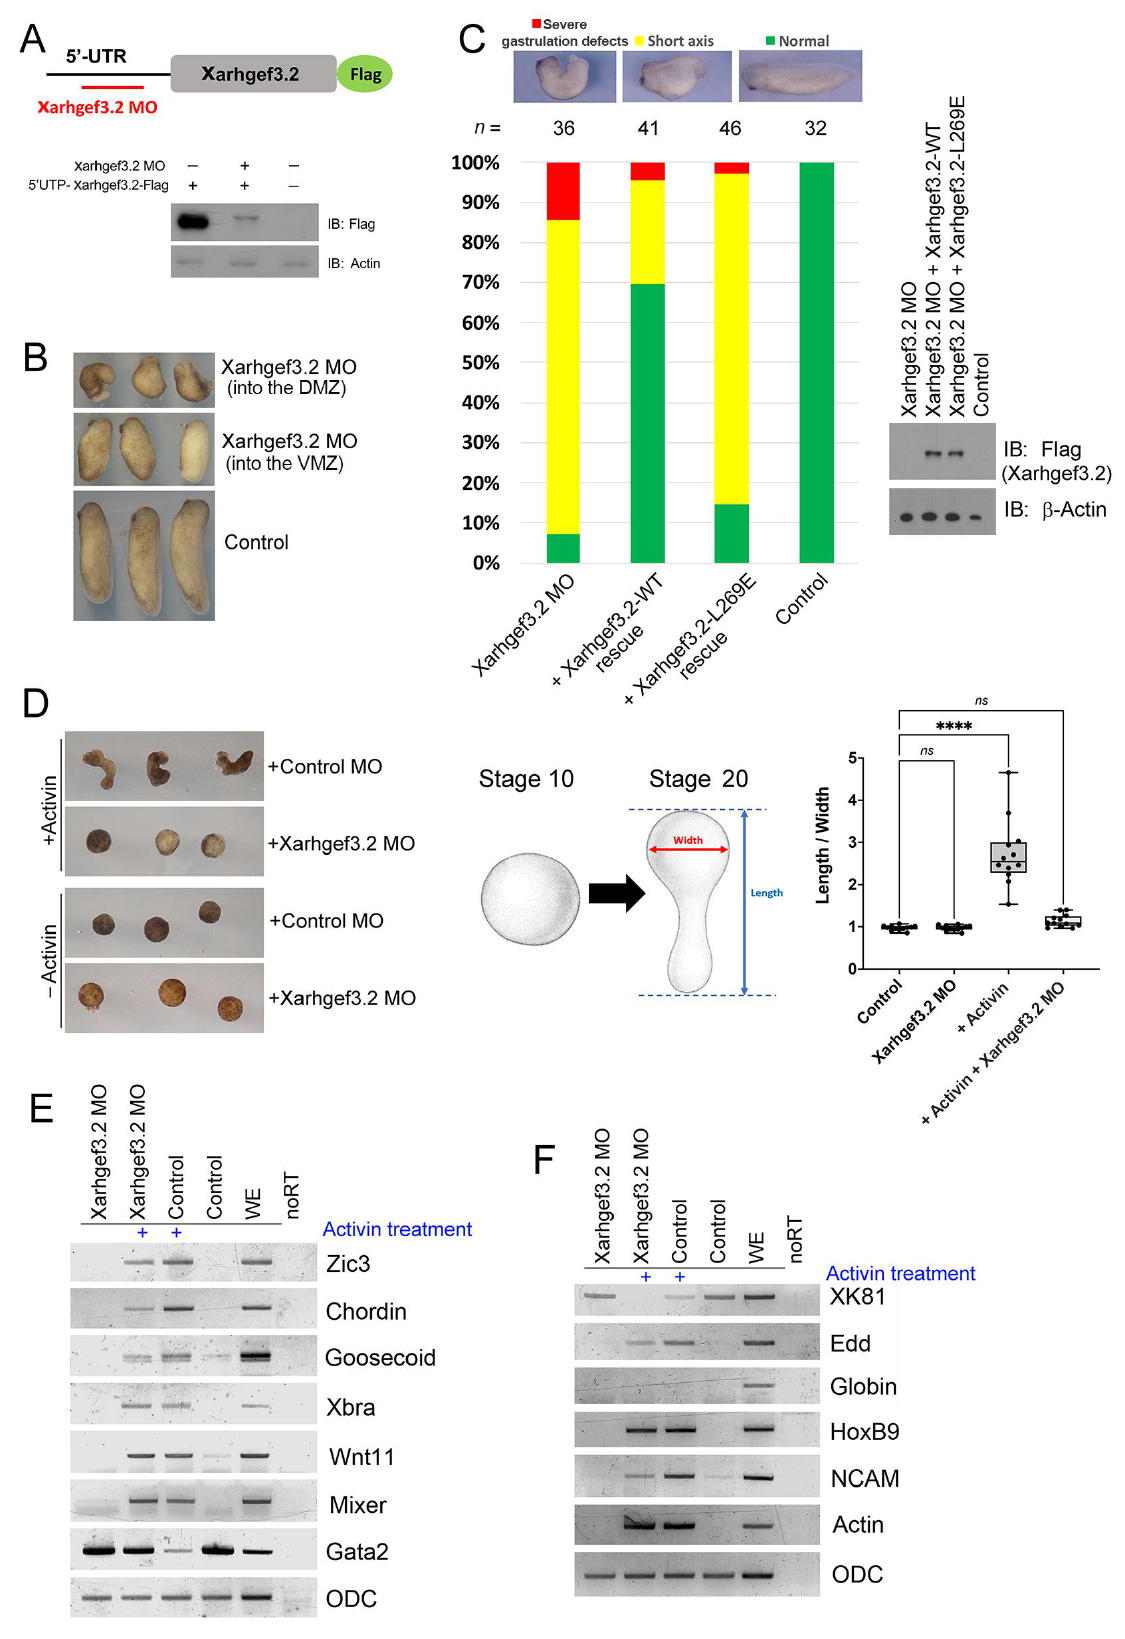
Figure 4. Knockdown of Xarhgef3.2 leads to a gastrulation defect without affecting the cell fate. ( A ) The whole embryos were injected with RNAs of the 5′UTR -Xarhgef3.2-3Flag construct (100